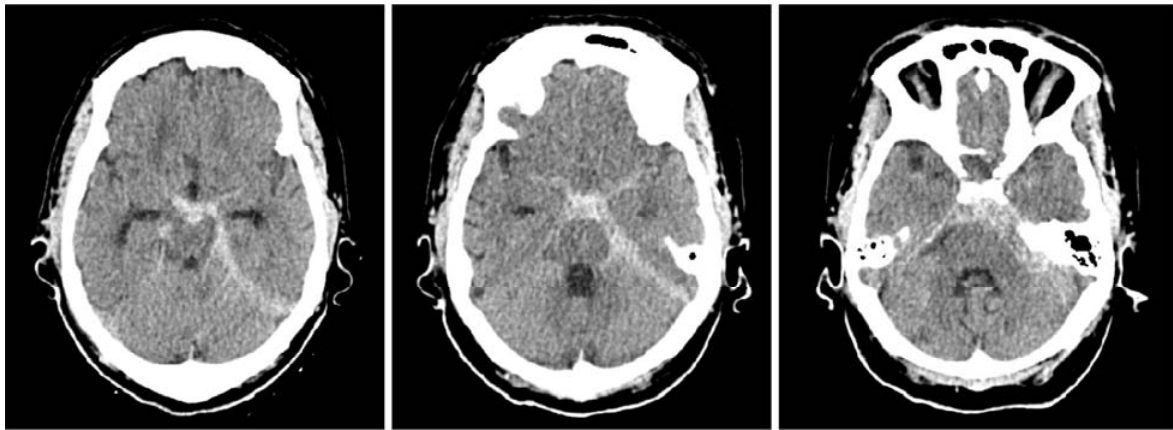
Figure 1. Magnetic resonance angiography of a 79-year-old woman with fusiform aneurysm of the basilar artery apex measuring 9.3 × 5.0 × 7.0 mm in transverse, anteroposterior and cranio-caudal dimensions, respectively